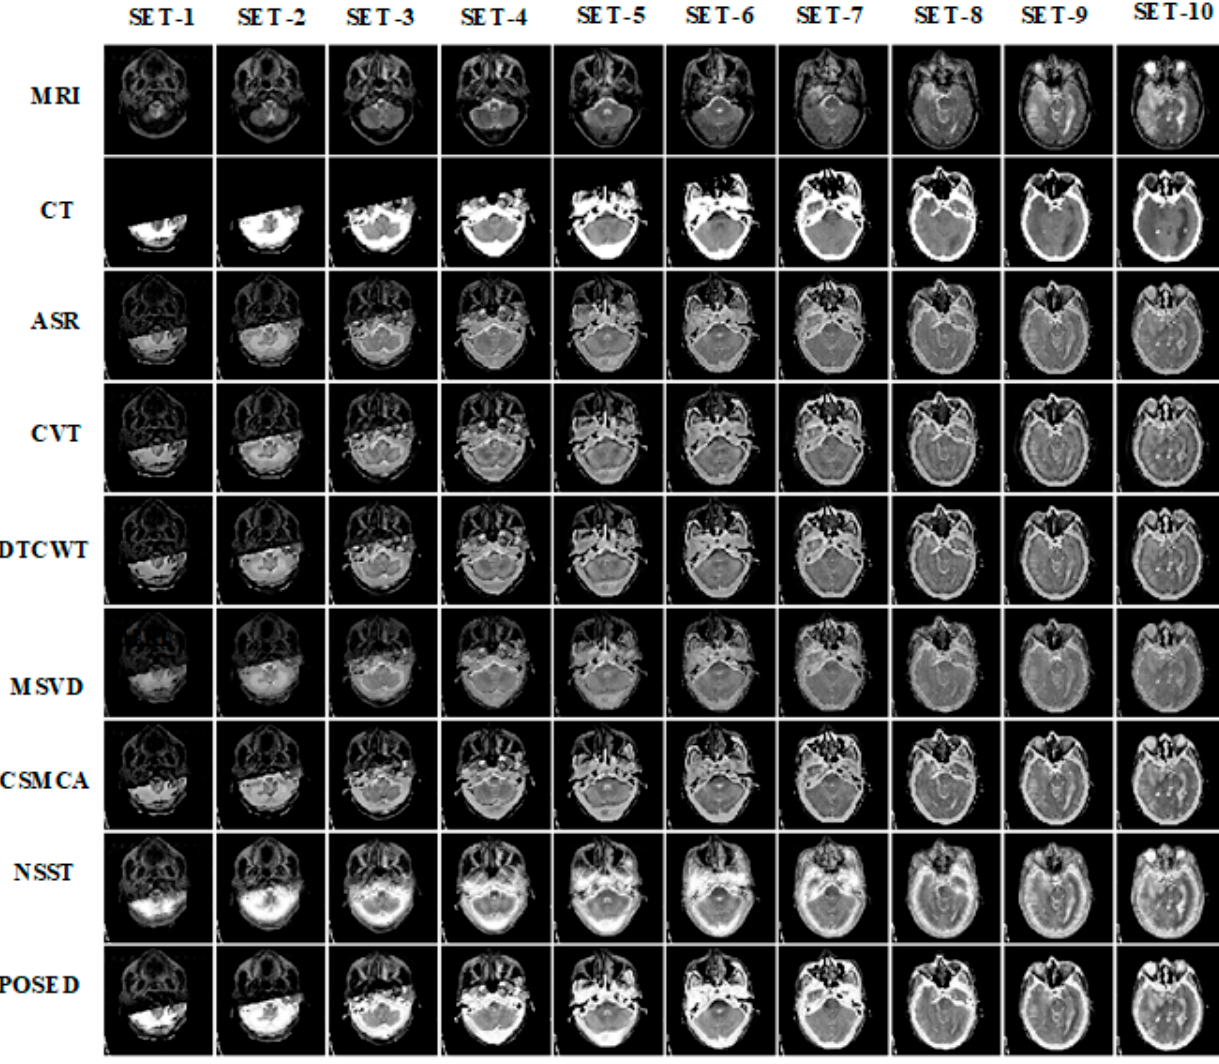
Figure 9. The results of various methods on next 13 pairs of MRI-CT images (fatal stroke).